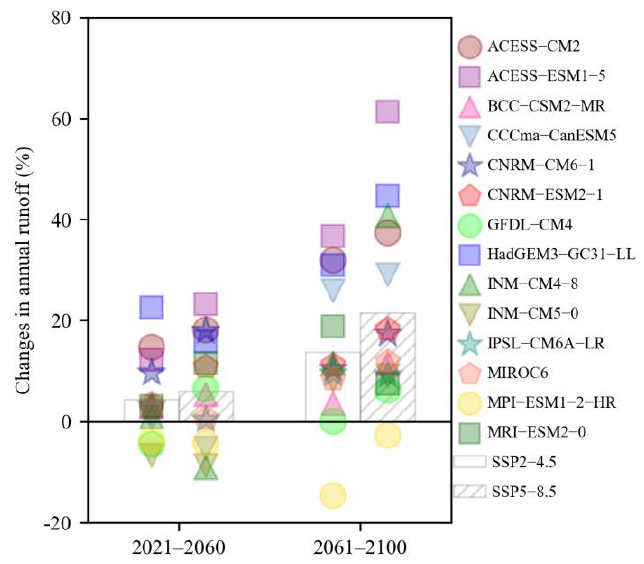
Figure 5. Simulated changes in annual runoff in the Fujiang River basin for 2021–2060 and 2061–2100 under 14 GCMs and 2 SSP-RCPs (relative to 1971–2010).